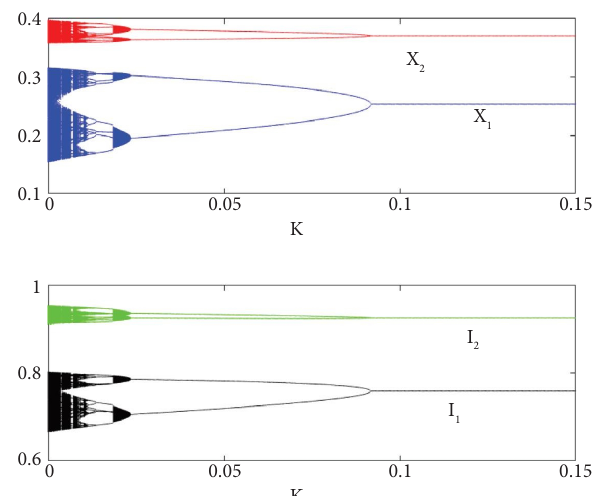
Figure 7: Bifurcation diagram of a discrete dynamical system (21) with the change of feedback gain intensity.